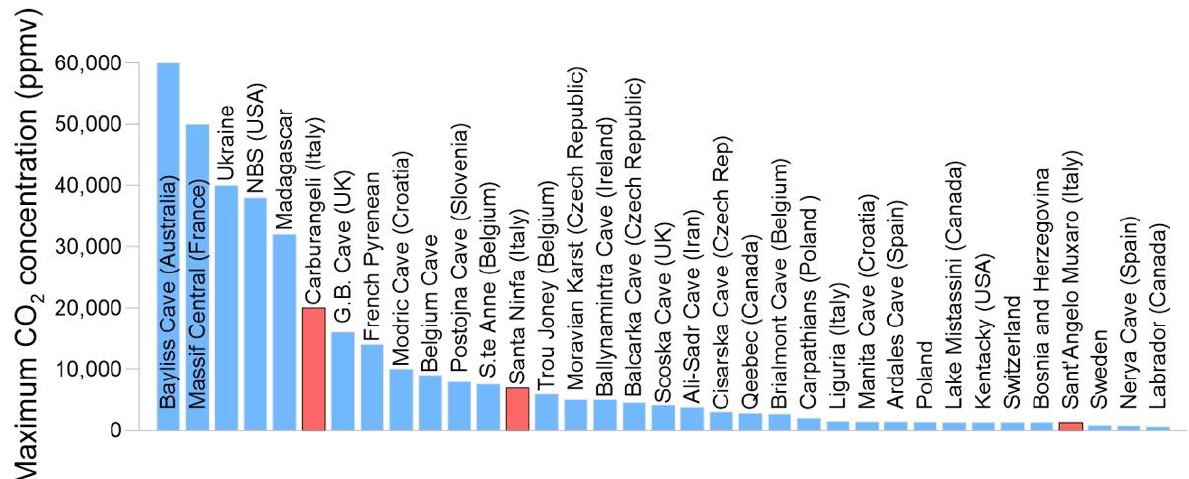
Figure 12. Maximum measured air CO 2 concentrations in the studied caves (red bars) compared to those from literature data (blue bars) [20 – 32].